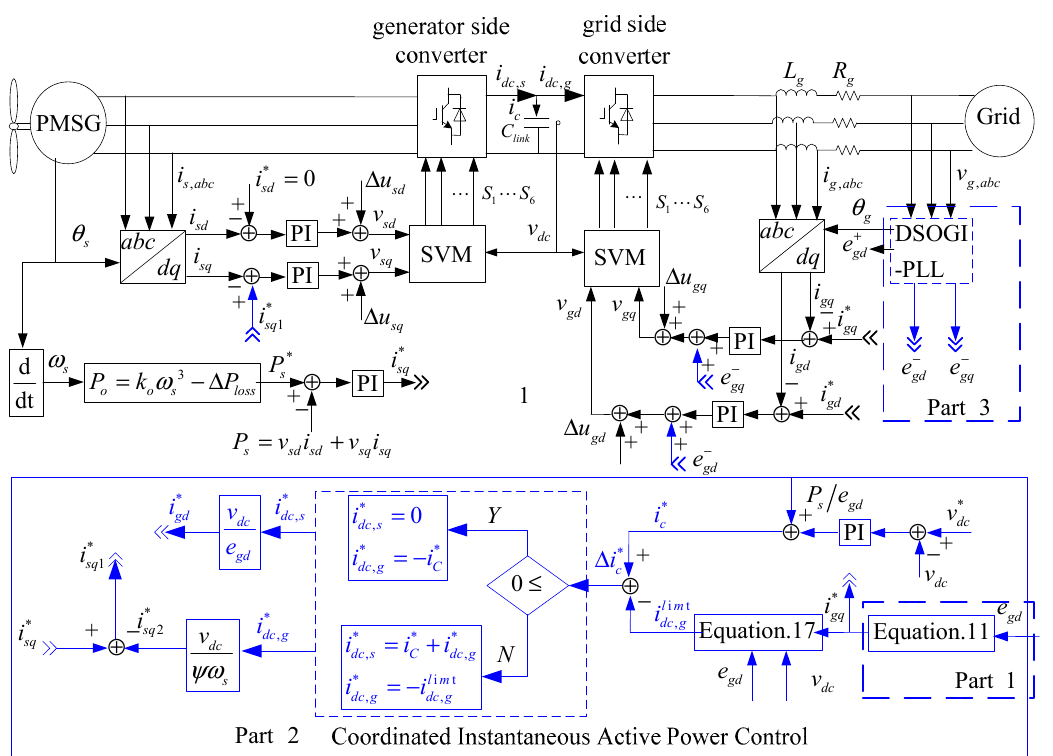
Figure 2. The diagram of an improved control strategy of LVRT based on active power coordinates’ control. DSOGI-FLL, Dual Second-Order Generalized Integrator Frequency-Locked Loop.